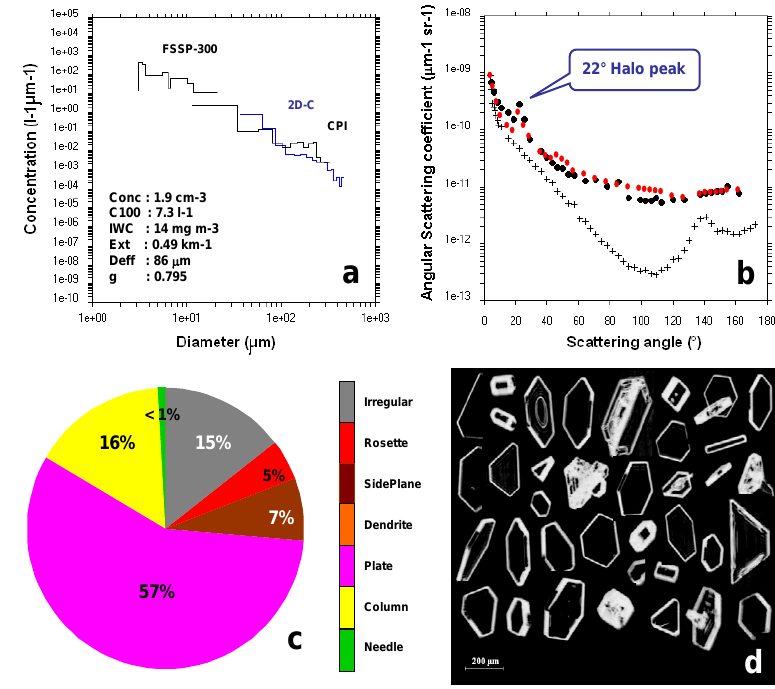
Fig. 4. Same as in Fig. 2. Mean cirrus cloud properties averaged between 09:02:10 and 09:02:30 (see Fig. 3).